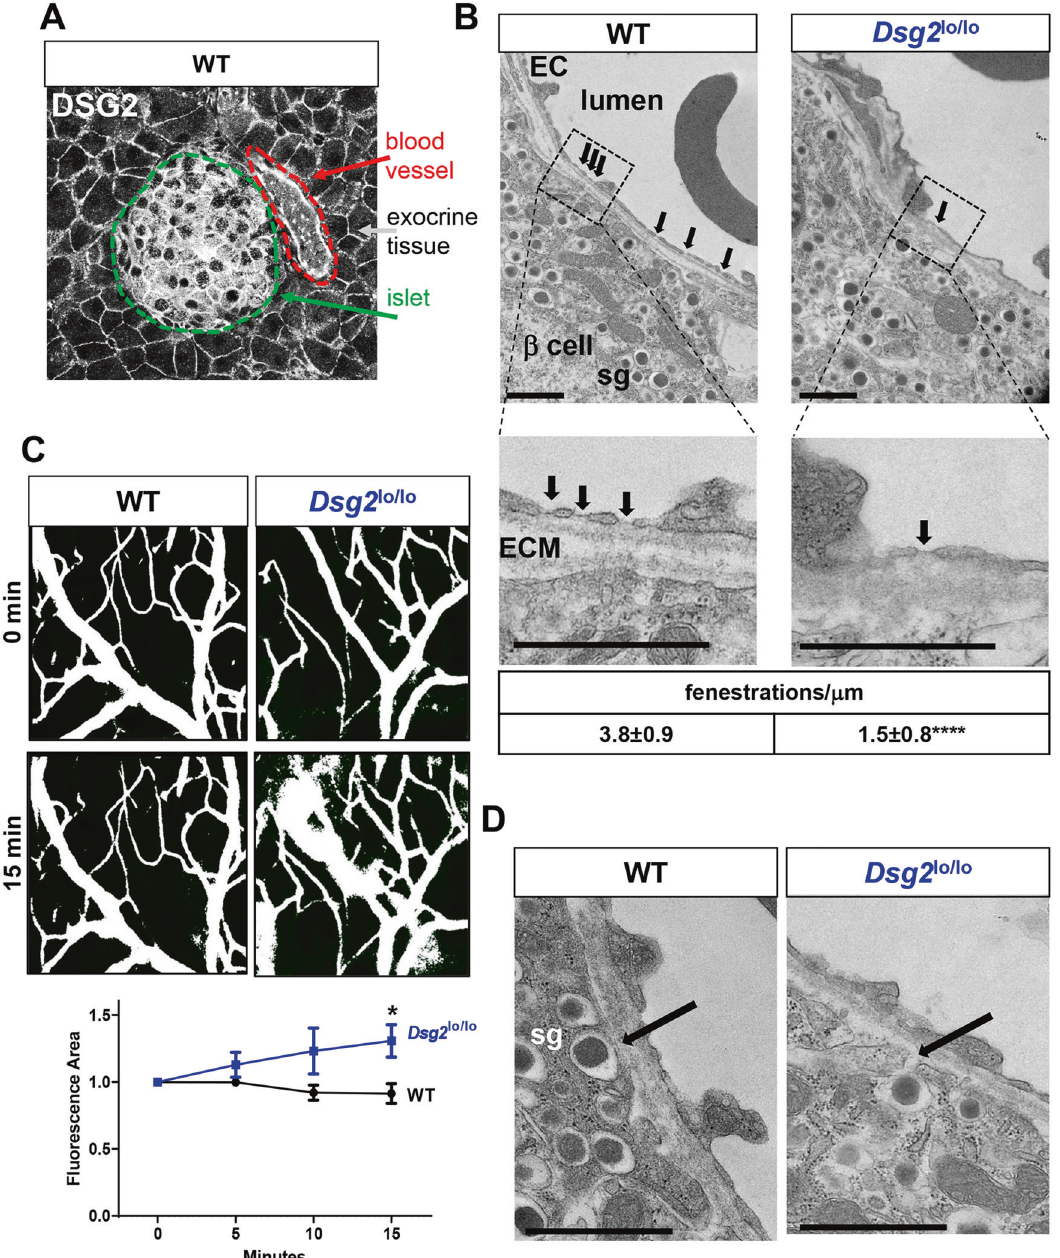
Fig. 4 Ultrastructural analysis of pancreatic islets and vasculature in WT and Dsg2 lo/lo mice. A Immuno fl uorescence confocal microscopy of a WT mouse pancreatic islet stained for DSG2 with DSG2 + pancreatic islet (demarked in green) and DSG2 + blood vessel (demarked in red). B Transmission electron microscopy (TEM) of pancreatic islets in WT and Dsg2 lo/lo mice showing the vasculature endothelial cells (EC) with the lumen on one side and the β -cell on the other. Arrows indicate the EC fenestrations and the insert below shows the sieve plates of fenestrae counted per μ m length of vessel lining from n = 6 – 16 islet-associated vessels from 2 mice per group. **** p < 0.0001 vs WT, scale bar = 1 μ m. C Anaesthetised mice (WT and Dsg2 lo/lo ) were injected i.v. with 70 kDa FITC-Dextran prior to intravital 2-photon microscopy of the ear. Snapshots of 0 and 15 min time points were quanti fi ed via mean normalised fl uorescence of Dextran signal ± SEM ( n = 5 – 6 mice), * p < 0.05 vs WT at 15 min. D arrows identifying the membranes encasing the insulin-containing granules with their typical electron-dense core. Scale bar = 1 μ